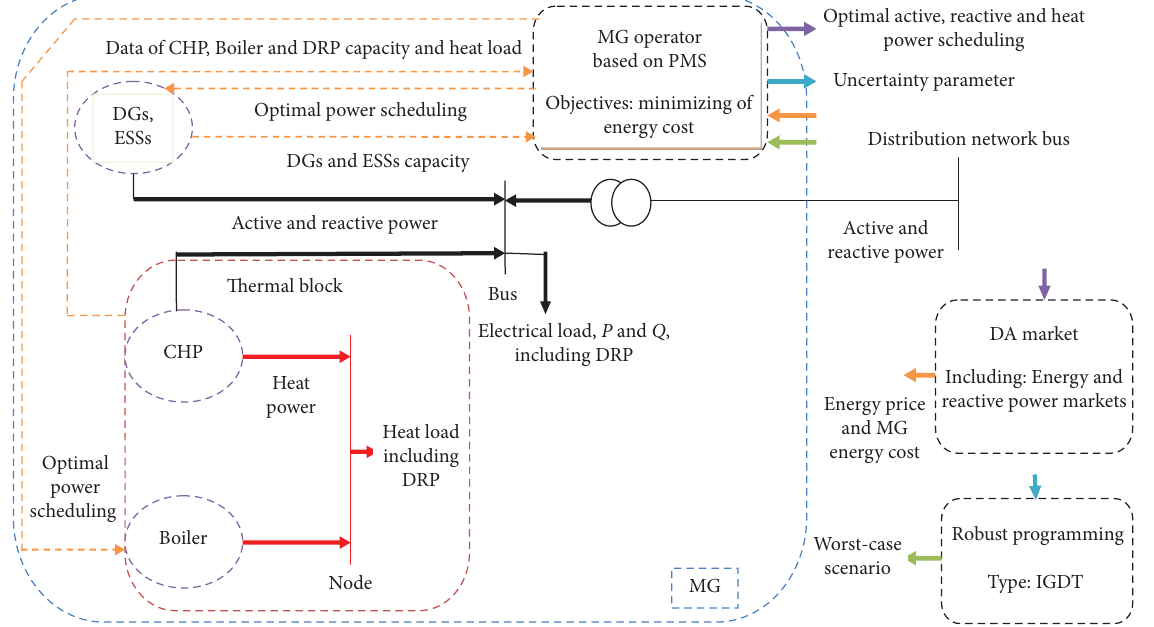
Figure 1: Framework of the proposed MG